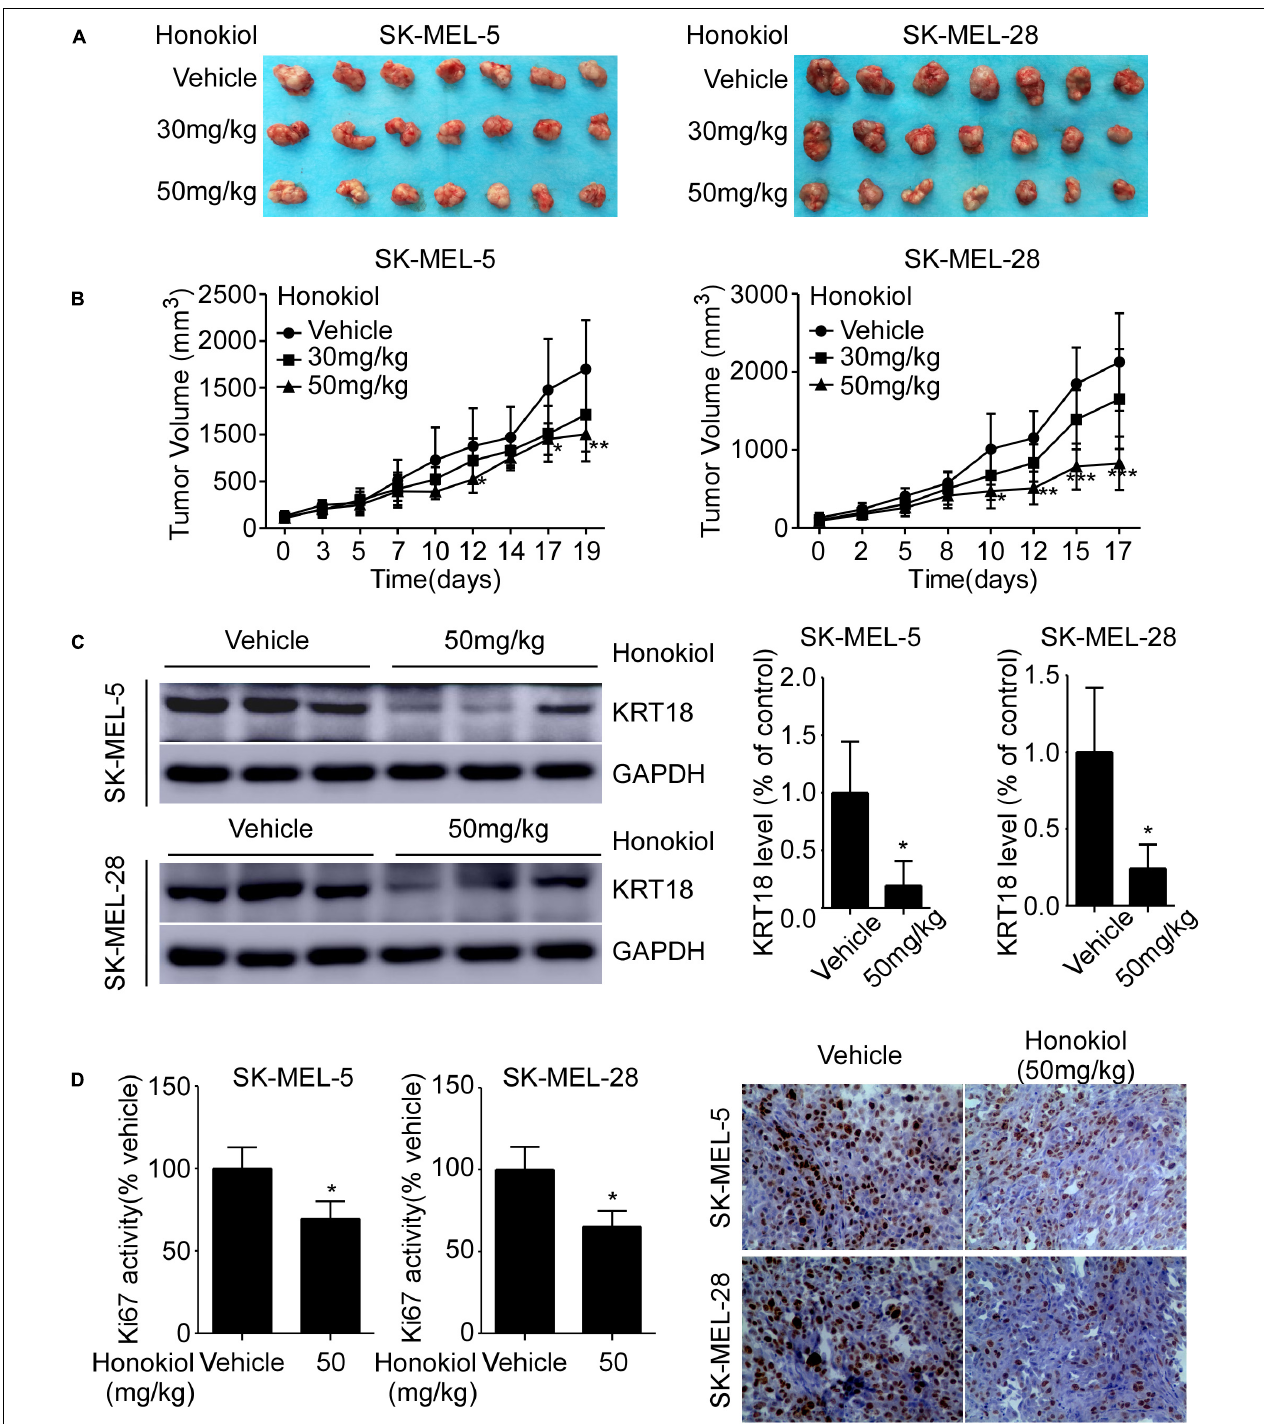
FIGURE 6 | Honokiol inhibits melanoma cell-derived tumor growth in vivo . SK-MEL-5 or SK-MEL-28 melanoma cell-derived xenograft mice models were established and treated with varying concentrations of honokiol. (A) Morphology of tumors after honokiol treatment. (B) Effect of honokiol treatment on melanoma growth. Tumor size was measured twice a week and volume was calculated, as indicated in materials and methods. (C) KRT18 protein level in random three tissues of vehicle and 50 mg/kg honokiol groups, as detected by western blotting (left) followed by densitometric quantification (right). (D) Expression of Ki-67 in vehicle group or 50 mg/kg honokiol treatment group tumors, as assessed by IHC staining. Quantitation of Ki-67 (left); Representative images (right). Bar graphs quantifying the number of Ki-67 stained cells by IHC staining through image scope. The asterisks indicate a significant difference (* p < 0.05,** p < 0.01, *** p < 0.001) between the vehicle and honokiol treated